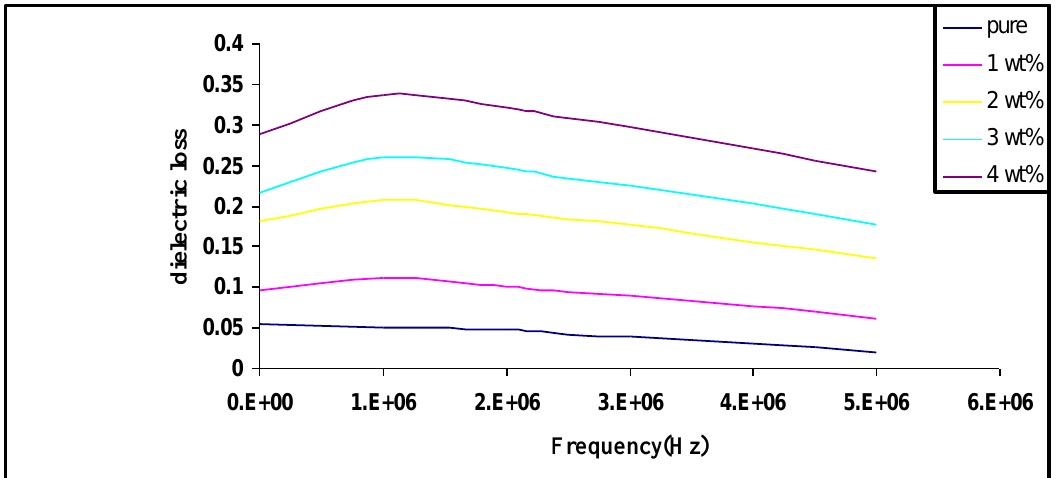
Fig.2 : Dielectric loss as a function of the angular frequency of PVA-NaI